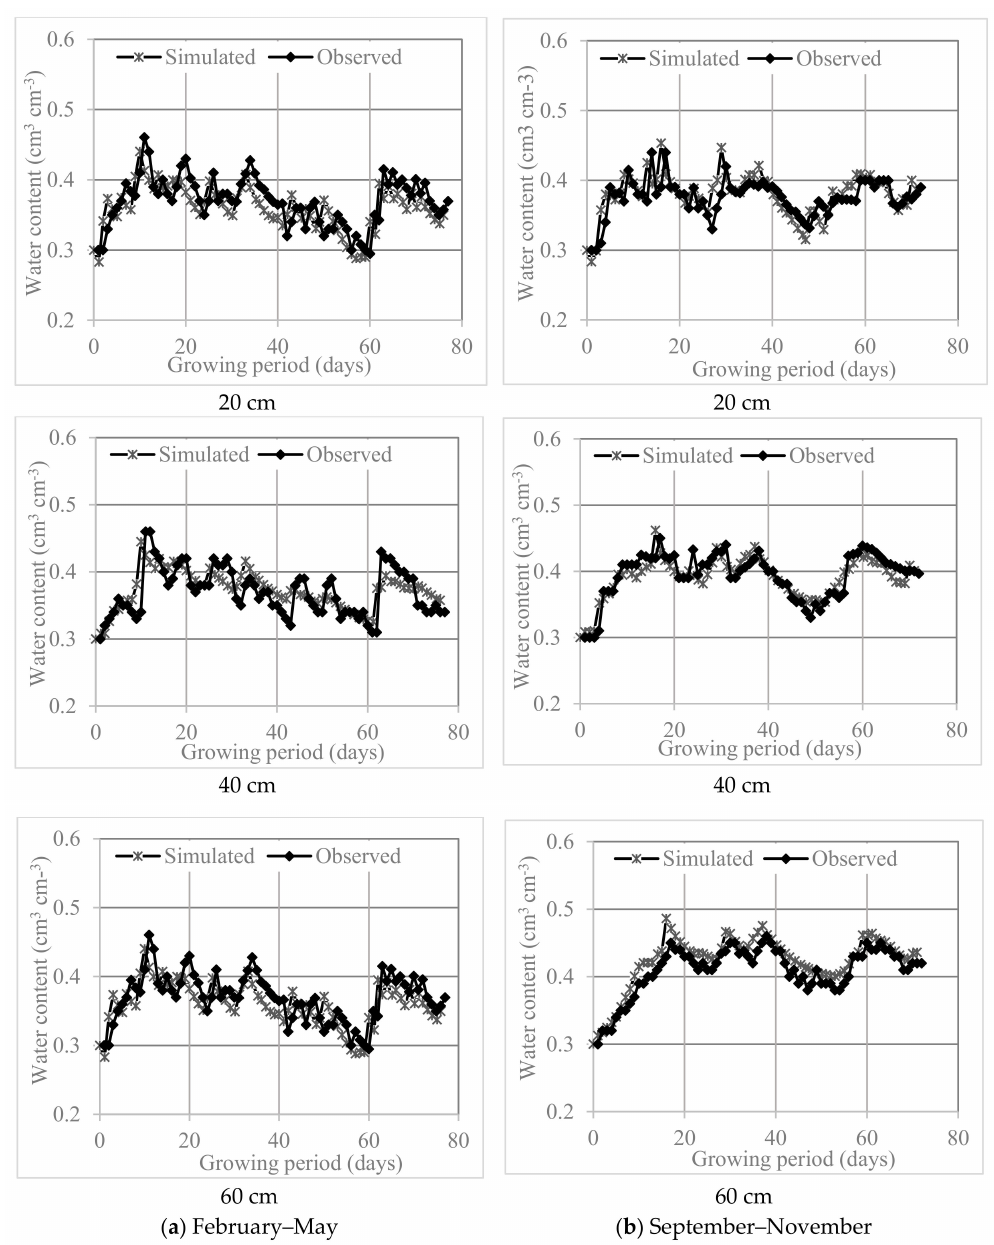
Figure 6. Simulated and observed soil water contents within the root zone (0–60 cm) during the ( a ) first season and ( b ) second